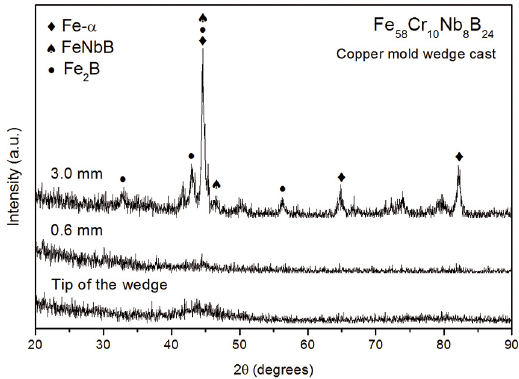
Figure 5: X-ray diffraction patterns of samples extracted from regions of different thicknesses of a copper mold wedge cast alloy.